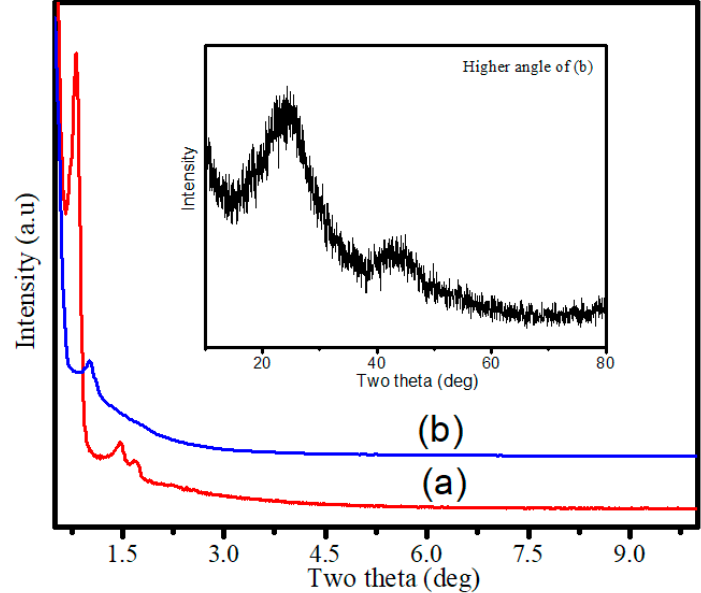
Figure 2. ( a ) XRD patterns of calcined SBA-15 silica template and ( b ) the rice starch-based nano/ ( a ) XRD patterns of calcined SBA-15 silica template and ( b ) the rice